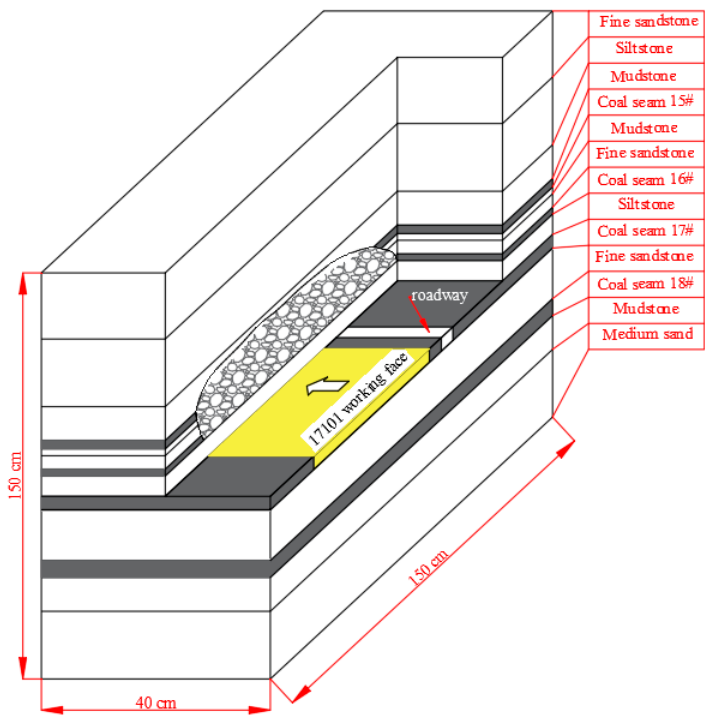
Figure 10. Excavation simulation plan diagram of coal seam 17#.